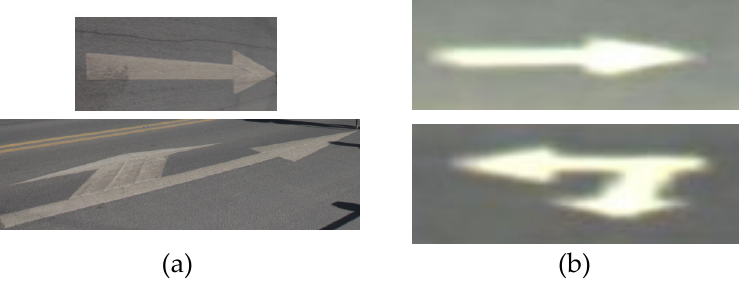
Figure 12. The selected traffic signs (( a ) measuring the checkpoints of traffic signs; ( b ) the enlarged